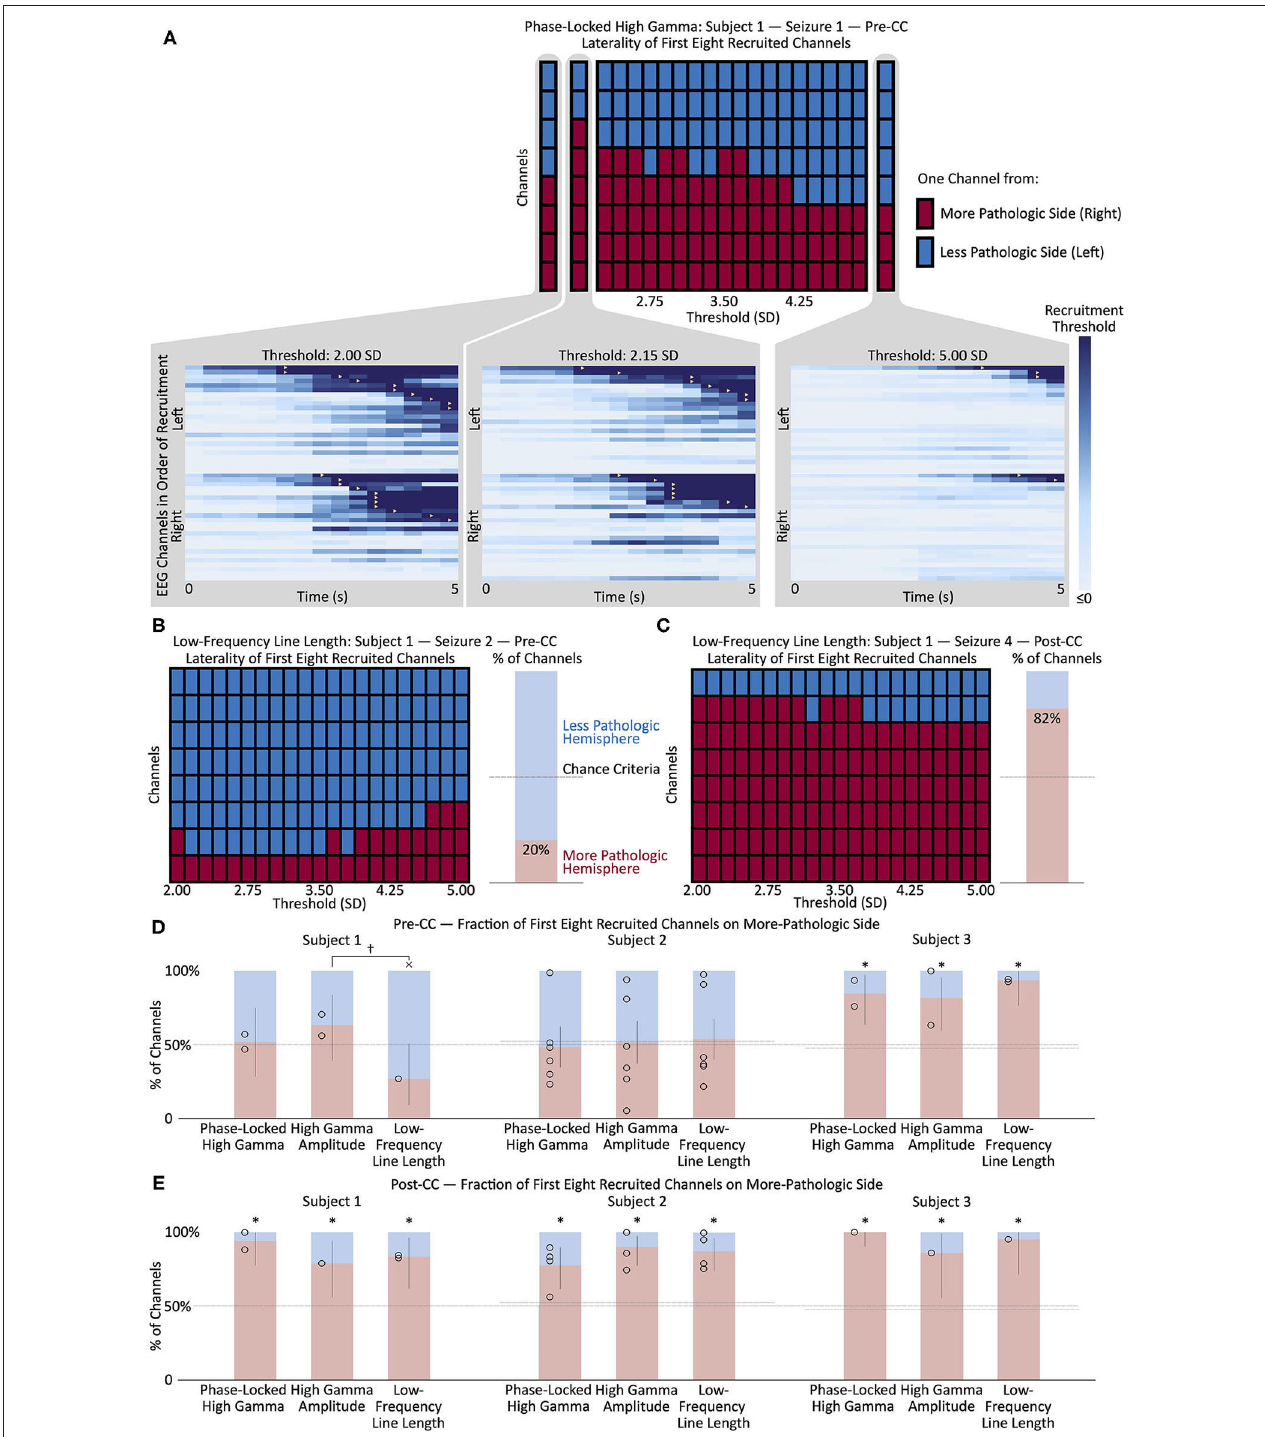
FIGURE 3 | (A) Change in the left/right distribution of the first eight channels recruited to a representative seizure (Subject 1, seizure 1) as a function of the recruitment threshold. Each red or blue square represents one channel from the right or left (more- or less-pathologic) hemisphere, respectively, and the horizontal axis shows how the distribution of the first eight recruited channels changes as a function of the recruitment threshold of the phase-locked high gamma value. Insets show the seizure onset, with each horizontal line representing the time evolution of the phase-locked high gamma in one channel, and color scaled to represent 0 through 2.00, 2.15, and 5.00 standard deviations above mean pre-seizure levels, respectively. Recruitment events, where the phase-locked high gamma exceeds threshold, are represented by yellow triangles. Note the change in recruitment patterns as the threshold is modulated. (B) Change in the left/right distribution of the first